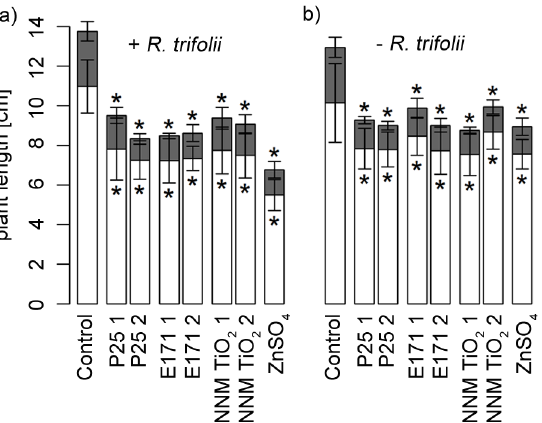
Fig 4. Length of the main root (white) and shoot (grey) at harvest (t = 4 weeks). Lengths are shown for the control, the different TiO 2 NP treatments in two concentrations 1 (low) and 2 (high) that are described in Table 2, and the 16.1 mg l -1 ZnSO 4 treatment (a) in presence of R . trifolii or (b) without R . trifolii . Significant (p < 0.05) differences to the respective control (n = 6) are indicated with asterisks above the standard deviation error bars for shoots, and below the error bars for roots. The results of the same treatments with and without R . trifolii are not significantly different and neither were the controls, but the root length of ZnSO 4 with and without R . trifolii was different (p = 0.005).